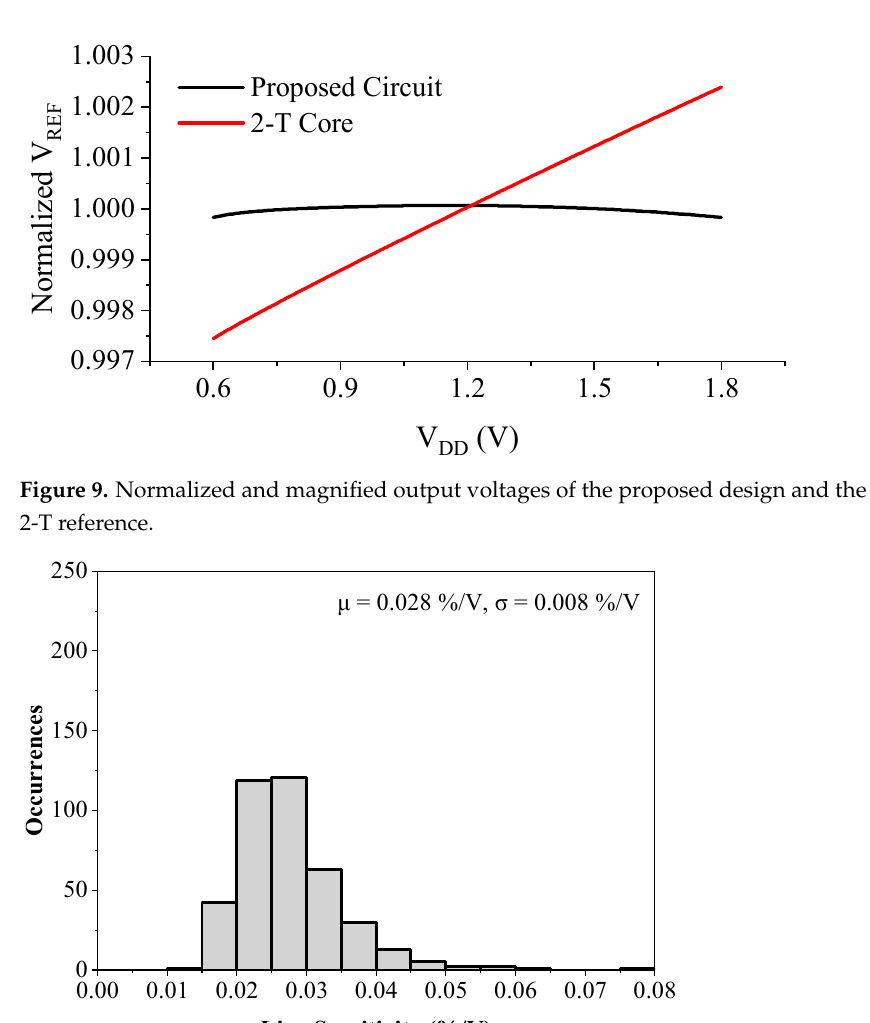
Figure 10. Monte Carlo simulation results for the line sensitivity of the circuit presented in Figure 2 (400 runs).